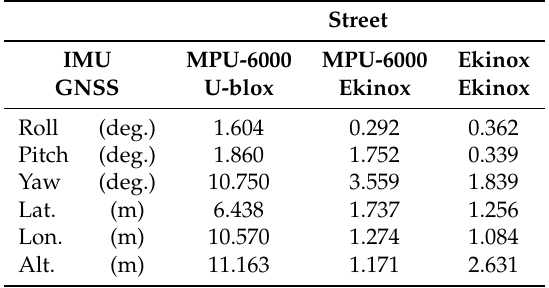
Table 5. RMSE from the three proposed navigation systems for the Street stretch.